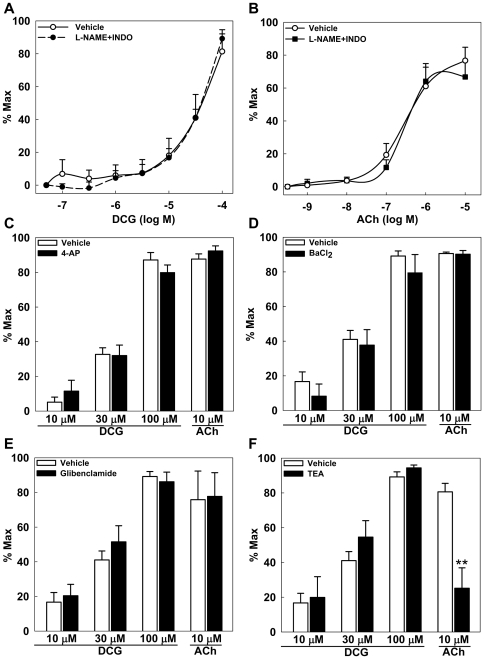
Role of NO and K+ channels in DCG- and ACh-induced reduction of MT in rat 4th-order mesenteric arteries.(A) DCG induced concentration-dependent reduction of MT in arteries incubated with L-NAME (300 µM) and INDO (10 µM). (B) ACh induced concentration-dependent reduction of MT in arteries incubated with L-NAME and INDO. (C–F) Addition of 4-aminopyradine (KV blocker, 1 mM), BaCl2 (KIR blocker, 30 µM), glibenclamide (KATP blocker, 10 µM) or TEA (KCa blocker, 10 mM) had no effect on DCG-mediated reduction of MT. Only TEA attenuated ACh-mediated reduction of MT; all experiments were conducted in the presence of L-NAME and INDO. Asterisks indicate significance when compared to vehicle-treated arteries. (n = 4–5 arteries in each group).